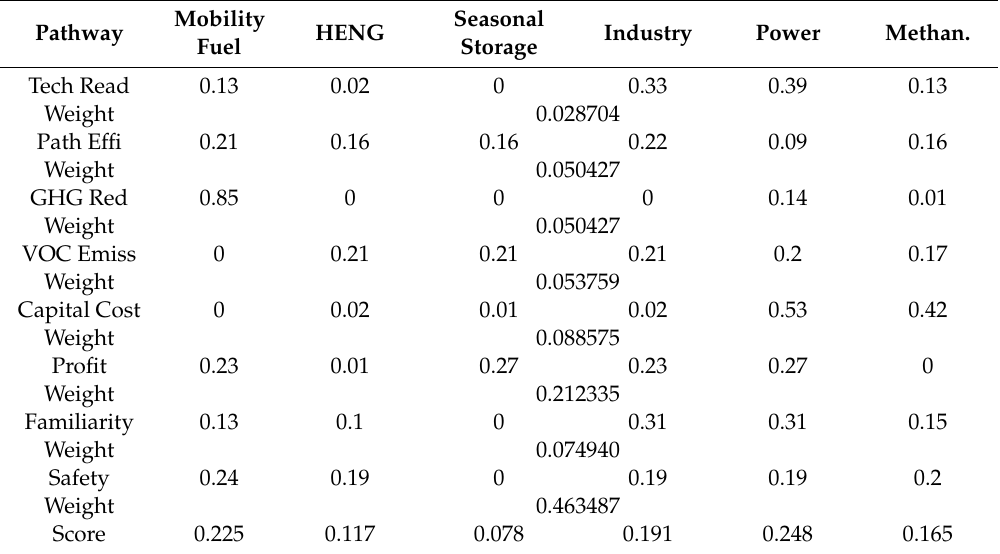
Table 21. Scores for Profitability Scenario (Source: own